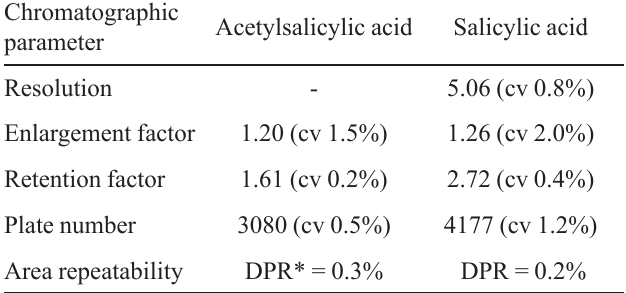
TABLE II - Resolution, enlargement factor, retention factor, plate number and repeatability of peak areas of acetylsalicylic and salicylic acids with their respective coefficients of variation